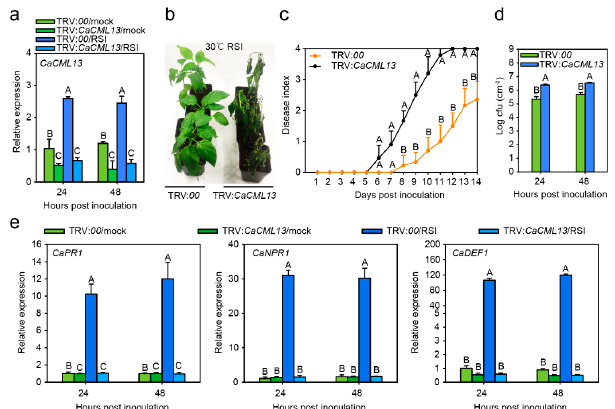
Figure 4. CaCML13 -silencing-impaired pepper immunity against RSI coupled with downregulation of PR genes. ( a ) Test of the success of CaCML13 silencing in TRV: CaCML13 pepper plant leaves challenged with RSI at the transcriptional level at 24 h post-inoculation; ( b ) bacterial wilt symptoms in the CaCML13 silenced and the control pepper plants at 11 days post inoculation by root-irrigation; ( c ) disease index from 5 to 14 dpi in CaCML13 silenced pepper and the control plants challenged with RSI; ( d ) growth of R. solanacearum displayed with cfu in CaCML13 silenced and the control pepper plant leaves challenged with RSI at 24 and 48 h post-inoculation; ( e ) relative transcript levels of immunity associated genes including CaPR1 , CaNPR1 and CaDEF1 were significantly downregulated by CaCML13 silencing at 24 h post-inoculation . In ( a , c – e ), data presented are means ± standard error of four replicates. Different uppercase letters above the bars indicate significant differences among means ( p < 0.01) by Fisher’s protected LSD test.